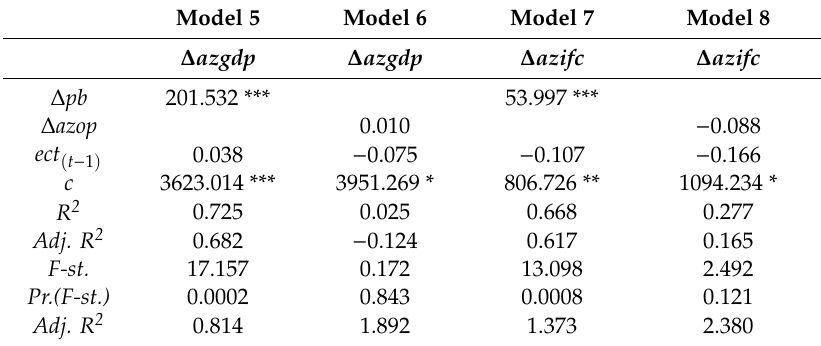
Table 2. The influence of oil price and oil production on GDP and investment on fixed capital